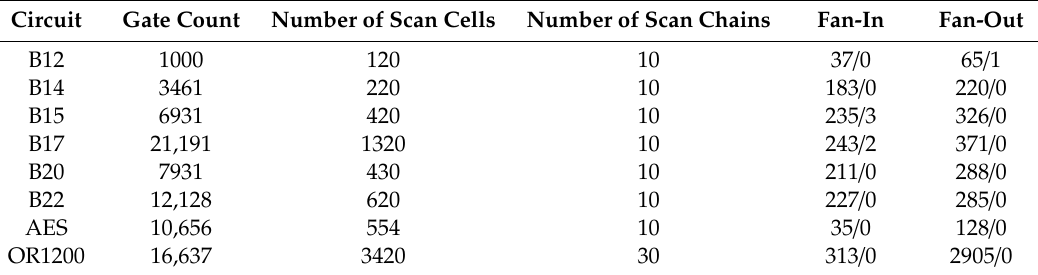
Table 4. Characteristics of benchmark